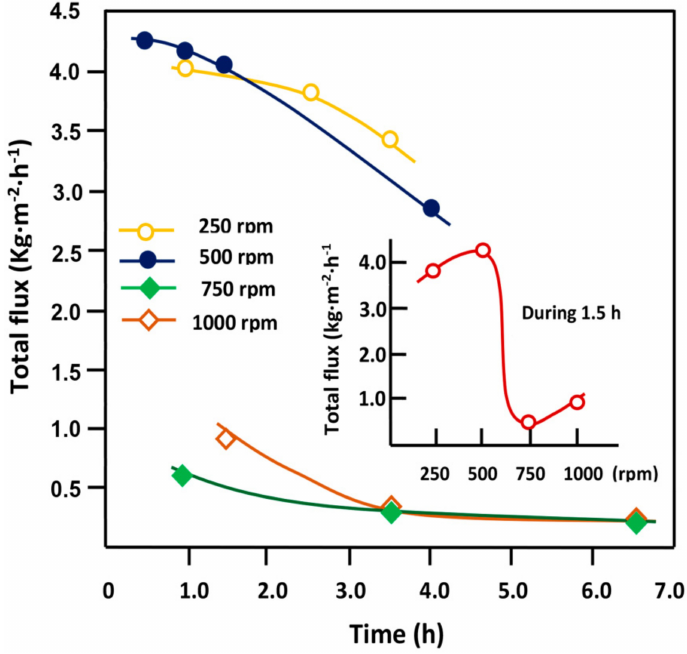
Figure 7. Variation of the total flux of the permeate versus time using a SILICONE1200-260 µ m membrane at different stirring rates.